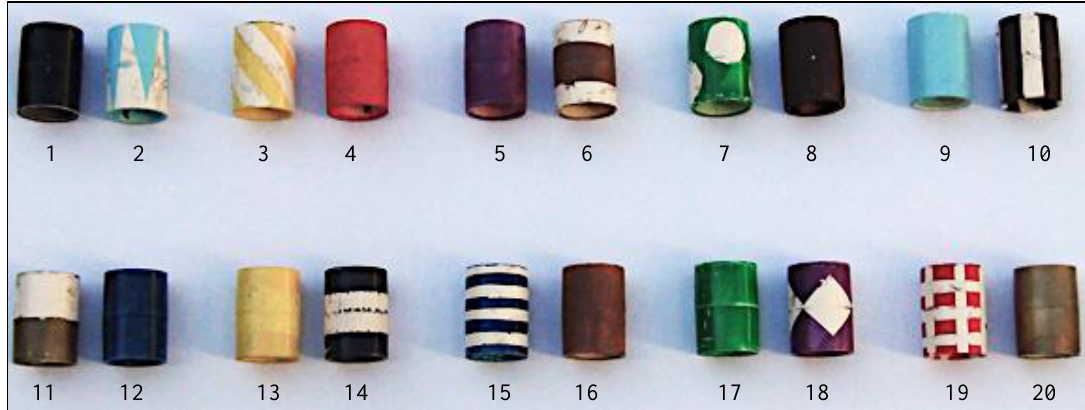
Figure 4 . Set of PVC tokens used in Study 2. Note that each pair (1-2, 3-4, 5-6, 7-8, 9-10, 11-12, 13-14, 15-16, 17-18, 19-20) was made of a patterned and a solid token, and one of these was always a darker color than the